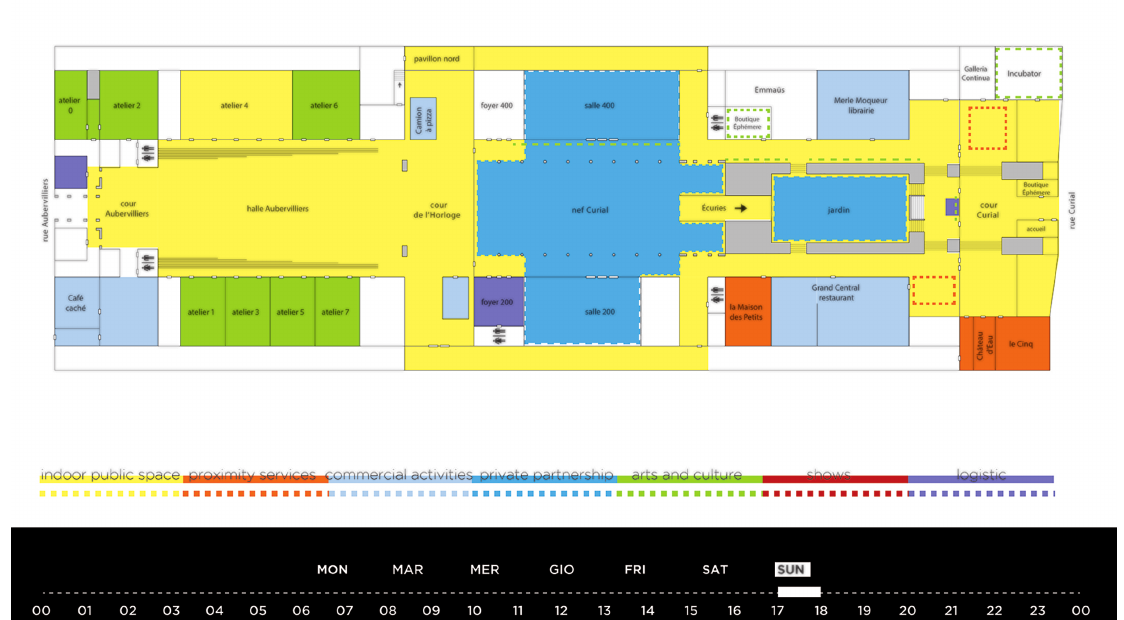
Figure 5. Chronocarta for 27 February 2017, 5 to 6 p.m. The building plan is a symbolic representation of its